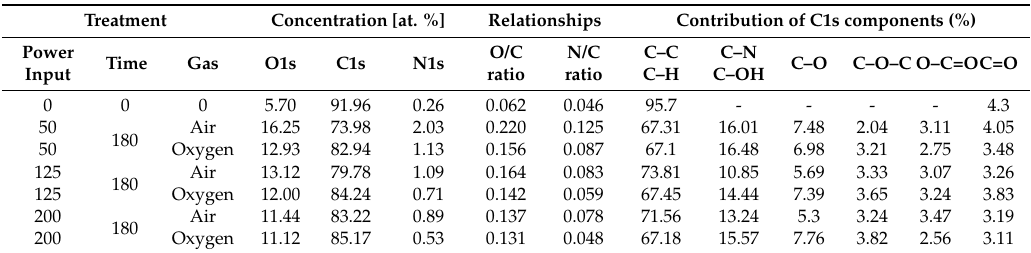
Table 3. Surface elemental composition and elemental ratio of the plasma-treated polypropylene substrate for different process